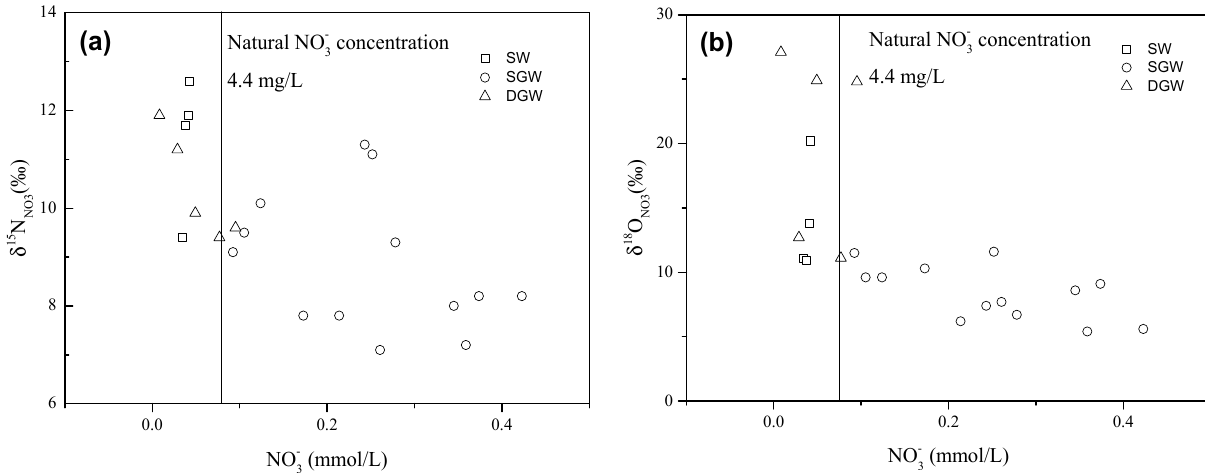
Figure 9. Relationship between isotopic composition of NO (cid:2871)(cid:2879) and NO (cid:2871)(cid:2879) concentration in the surface water and groundwater: ( a ) δ 15 N NO3 vs. NO − water; SGW: Shallow groundwater; DGW: Deep